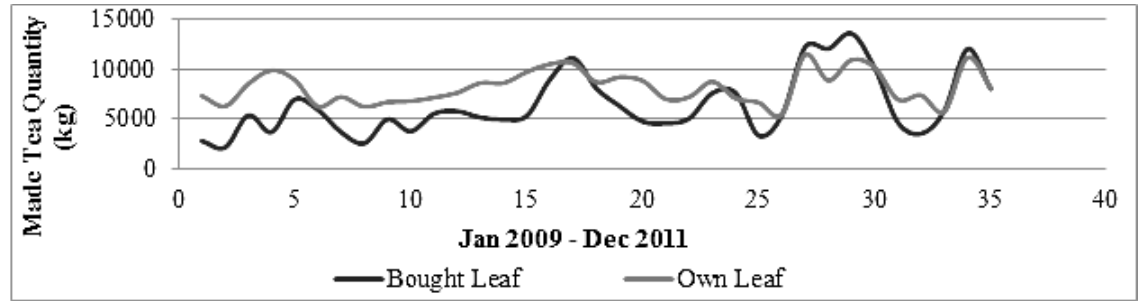
Fig 6: Behavior of Made Tea Produced by Own Leaf and Bought Leaf within Three Years Green Leaf Standard